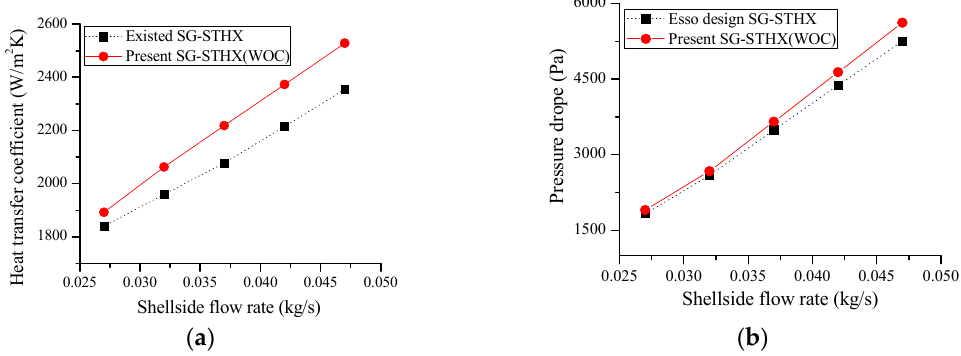
Figure 4. Model validation: ( a ) Comparison of the heat transfer coefficient of SGCT-STHX without tube-to-baffle-hole clearance with existed data and ( b ) comparison of the pressure drop of SGCT-STHX without tube-to-baffle-hole clearance with Esso design.